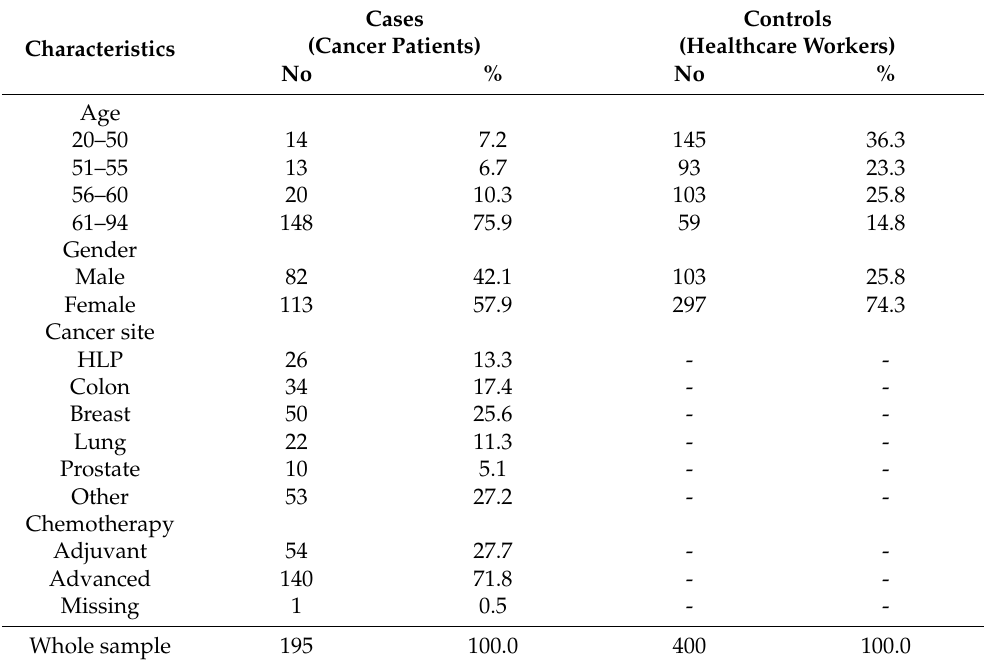
Table 1. Characteristics of cancer patients and of healthcare workers.